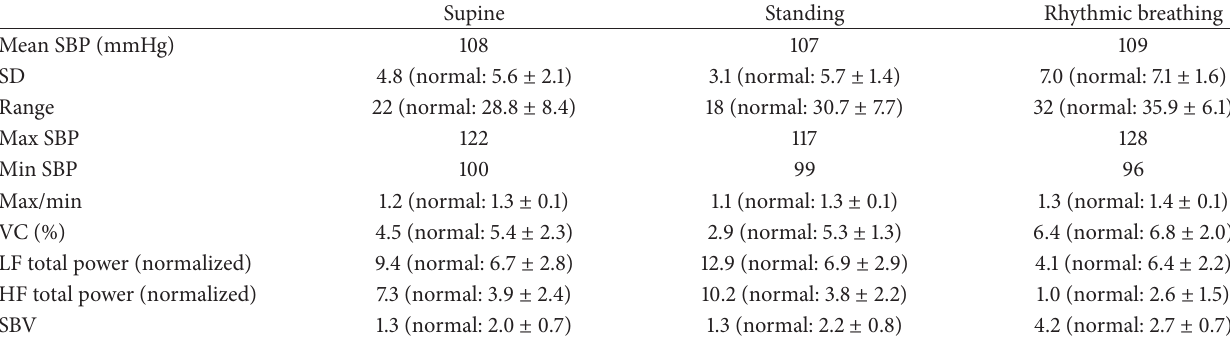
Table 2: Systolic blood pressure variability in the time and frequency domains.